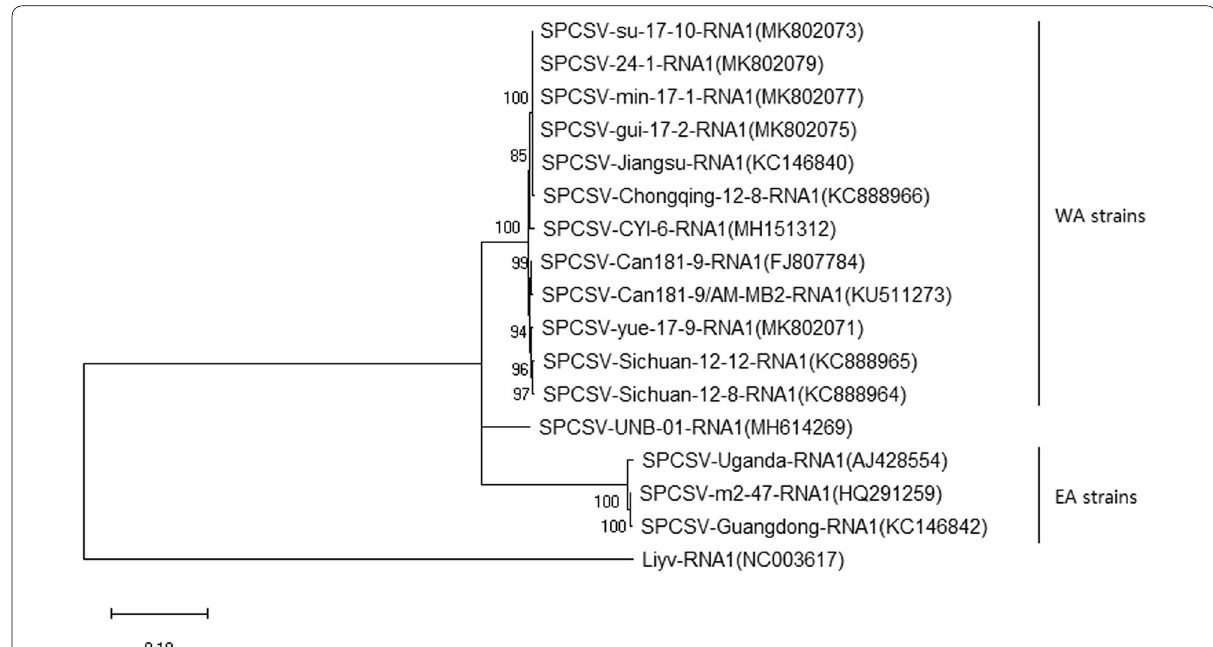
Fig. 3 Phylogenetic tree of RNA1 segments of SPCSV isolates. The tree was generated using MEGA X (the Maximum Likelihood method, General Time Reversible model and 1000 bootstrap replicates). Liyv RNA1 segment (NC_003617) was used as an outgroup